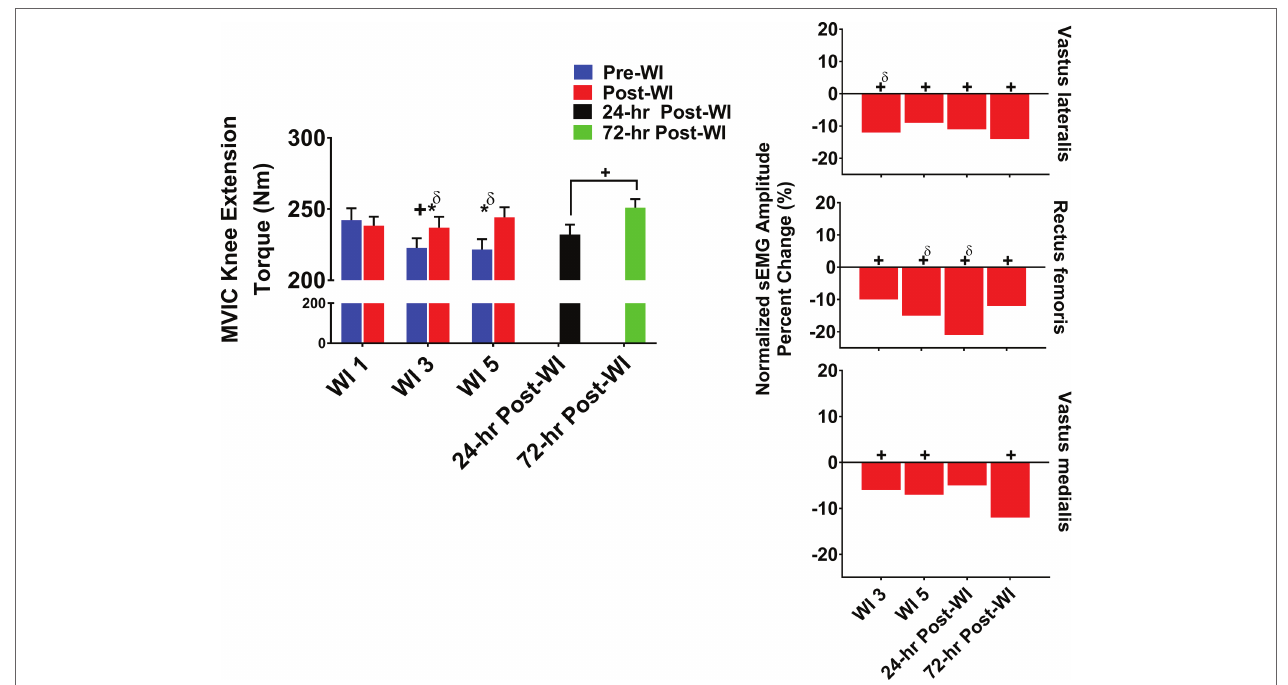
FIGURE 3 | MVIC knee extension results. Across subject ( n = 13) mean ± SEM is shown. Left graph – performance (force): post-WI performance was greater than pre-WI performance on WI 3 and 5. Additionally, performance declined by WI 3 but returned to baseline by WI 5. “*” denotes pre/post-WI main effect ( p < 0.05). “+” only denotes time main effect ( p < 0.05). Main effect symbol with “ δ ” denotes ( p < 0.001). Right graph – normalized sEMG day percent change: neuromuscular activation decreased throughout the dive week and through the recovery period when compared to WI 1 for all three knee extensors. “+” denotes time main effect ( p < 0.05). Main effect symbol with “ δ ” denotes ( p <